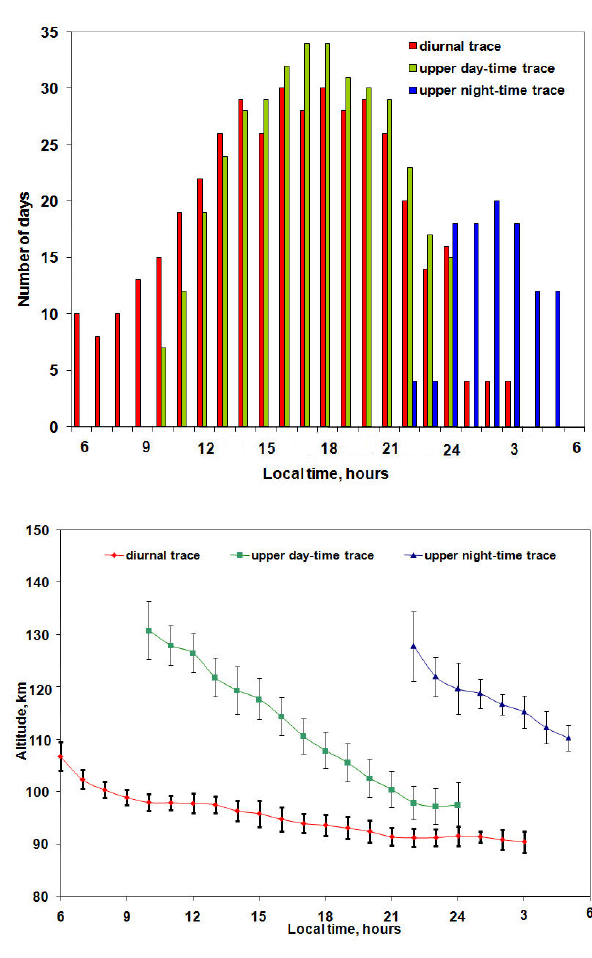
Fig. 5. Same as in Fig. 4 but for spring (March, April,